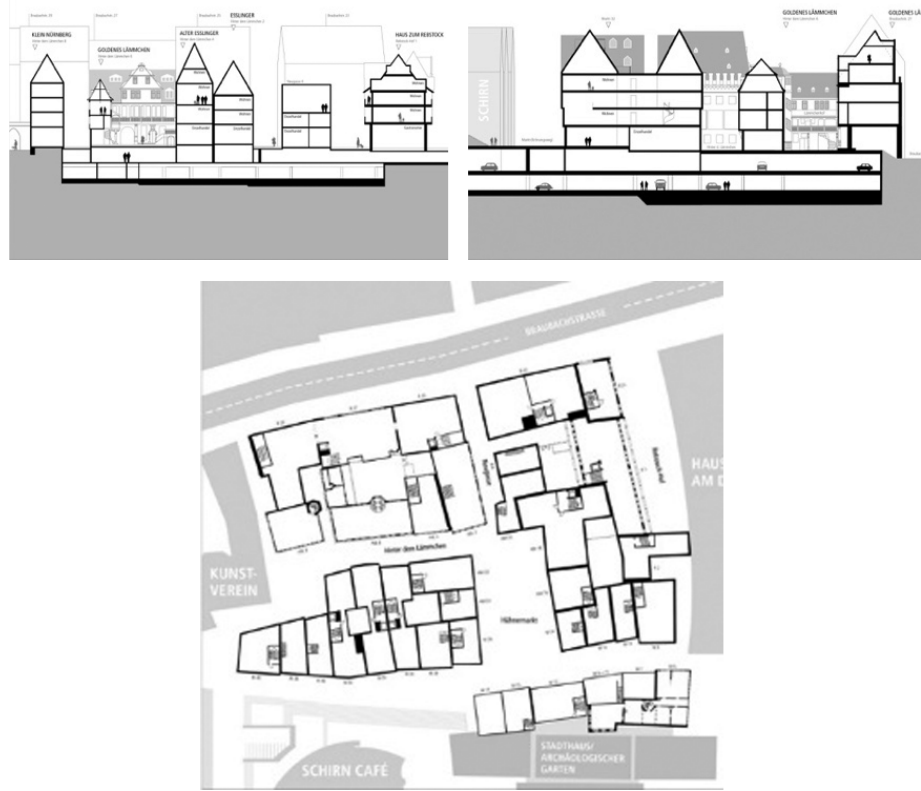
Figure 19. Frankfurt am Main. Top: Dom-Römer, sections; bottom: Dom-Römer ground-floor plan. Source: DomRömer (2011).